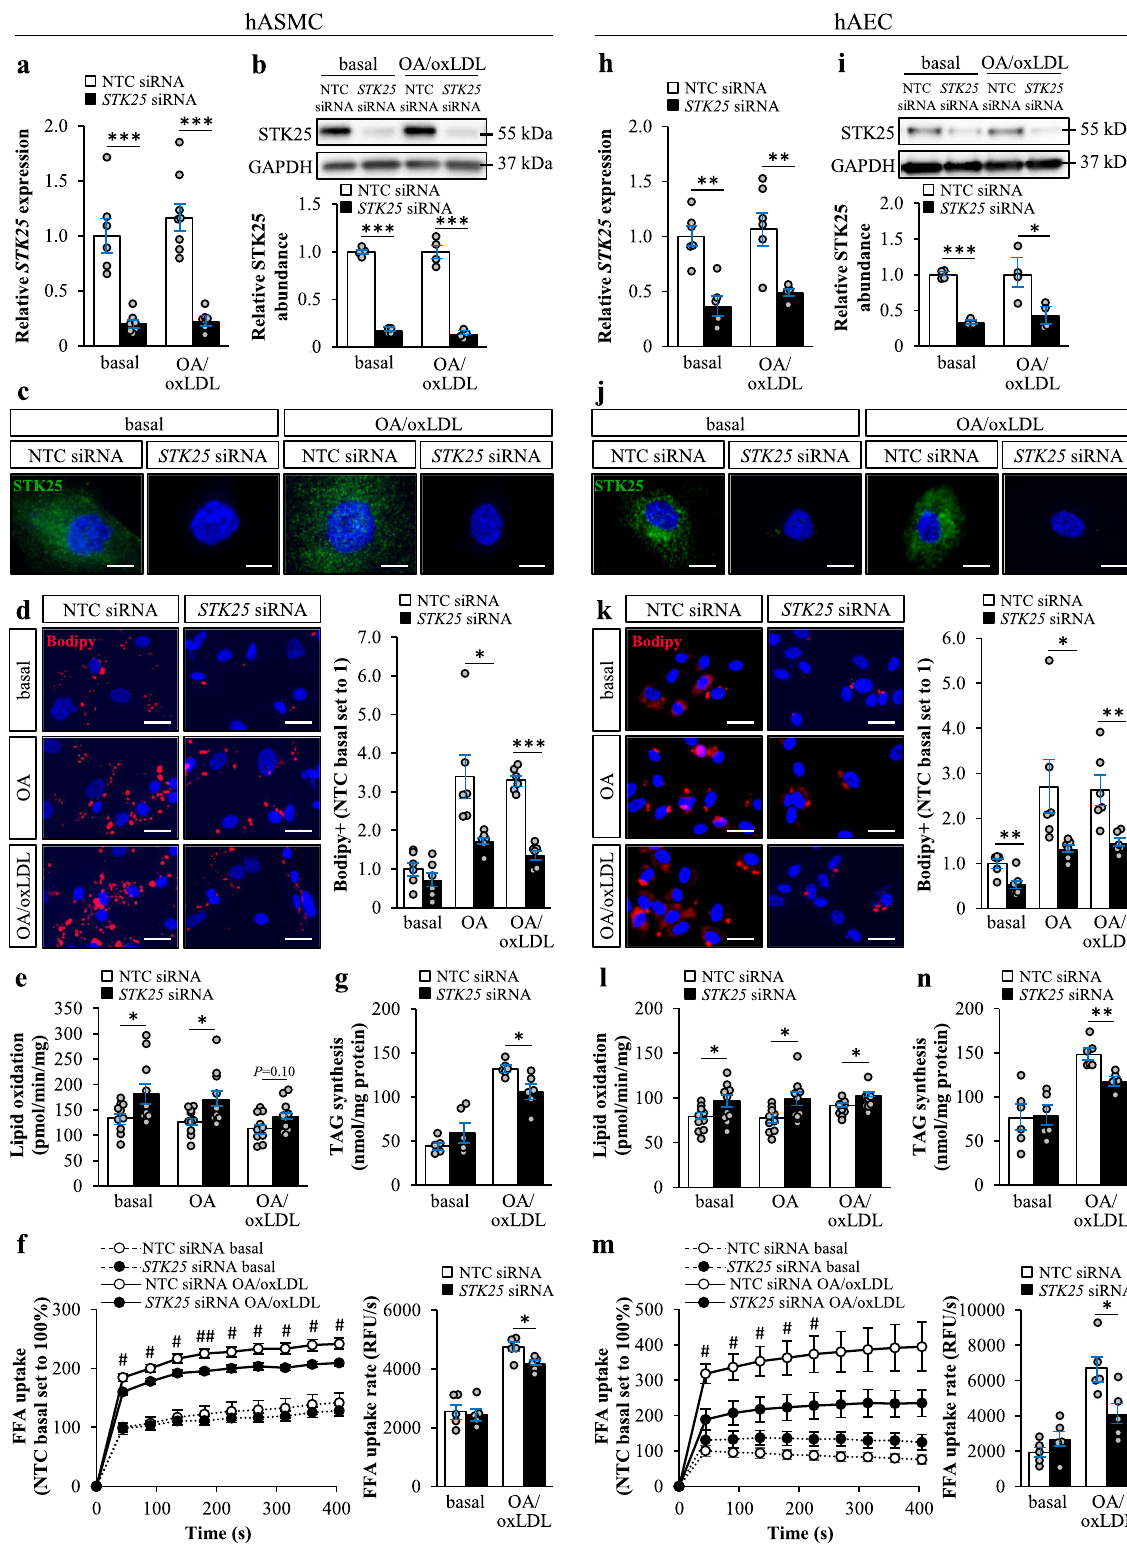
transfected with STK25 siRNA displayed signi fi cantly lower reactive of superoxide radicals (O 2 (cid:129) − ) quanti fi ed by dihydroethidium oxygen species (ROS) content when quanti fi ed using an ELISA kit, (DHE) staining, abrogated oxidative DNA damage detected by both with and without metabolic challenge (Fig. 3d, f). Oxidative immunostaining for 8-oxoguanine (8-oxoG), and protection against stress is known to contribute to aortic cell dysfunction primarily oxidized phospholipids measured by immunostaining for E06, through rapid inactivation of the key vasoprotective factor nitric when assessed after exposure to oleic acid and oxLDL (Fig. 3a – c). In oxide (NO) 4 . Here, lower ROS levels were accompanied by higher line with immunostainings, we found that hASMCs and hAECs COMMUNICATIONS BIOLOGY| (2022) 5:379 |https://doi.org/10.1038/s42003-022-03309-9|www.nature.com/commsbio